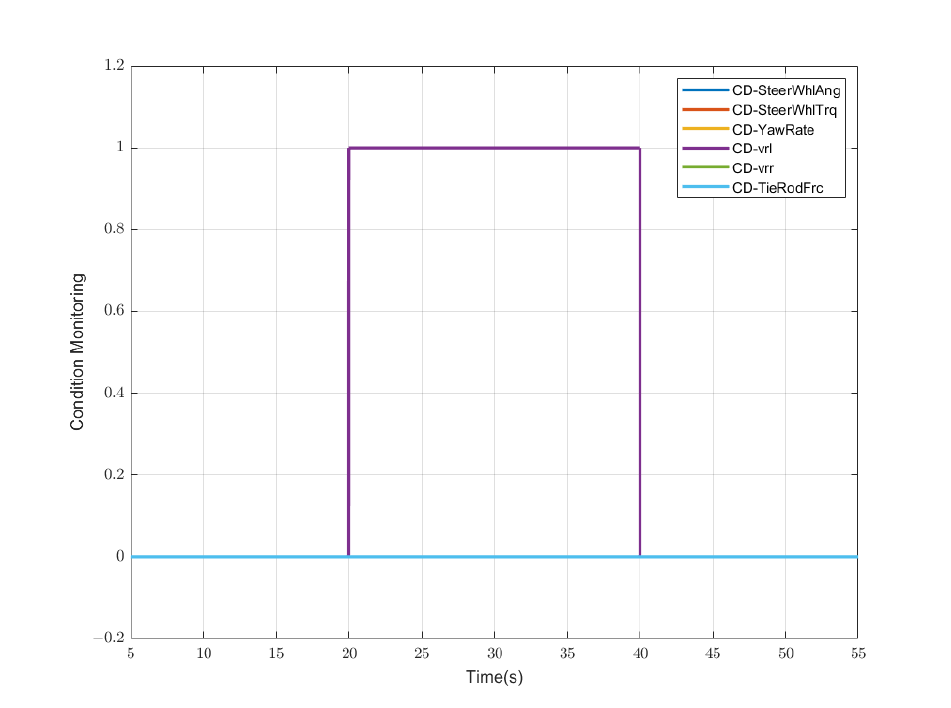
Figure 8. Result of sensor condition monitoring: the case is that the left rear wheel velocity fails between the 20 s and 40 s (“CD” is an abbreviation for “condition”, “0” refers to the normal state, “1” refers to the faulty state).